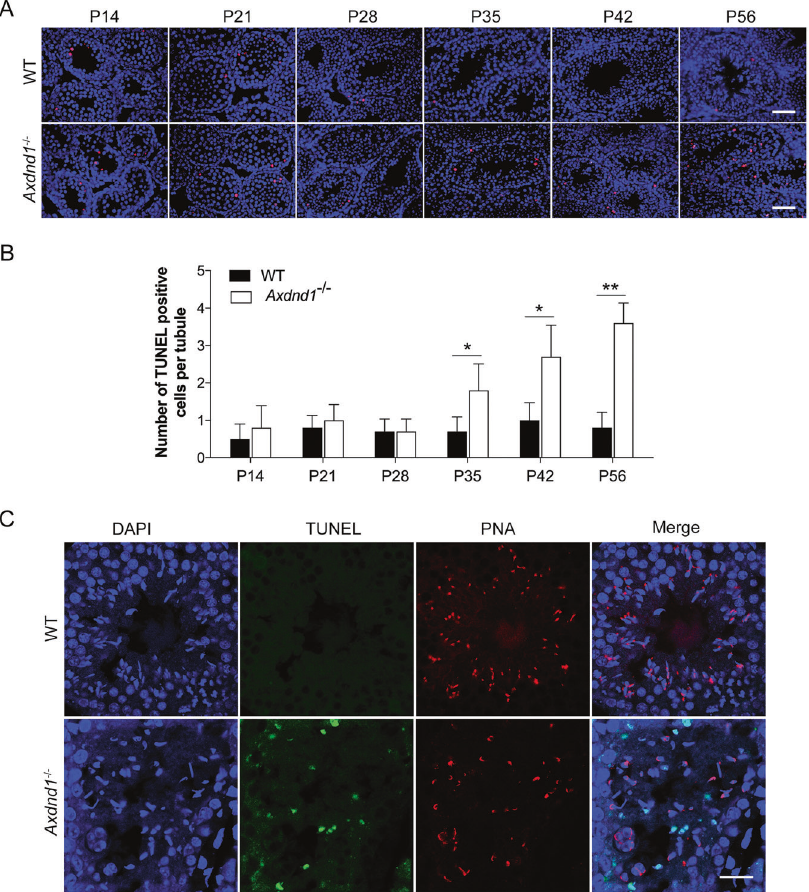
Fig. 5 Axdnd1 − / − mice exhibit signi fi cantly increased apoptosis of late spermatids. A Representative images of the apoptosis of germ cells in developmental testes were determined by TUNEL staining (red). Scale bar: 50 µm. B Quanti fi cation of the number of TUNEL positive cells in ( A ). Data are presented as Mean ± SEM, n = 3. * P < 0.05 by Student ’ s t -test. C Co-staining of TUNEL and PNA in the adult testes from WT and Axdnd1 − / − mice. TUNEL (green), PNA (red), and DAPI (blue) were used to mark the apoptotic germ cells, acrosome, and nuclei, respectively. Scale bar: 20